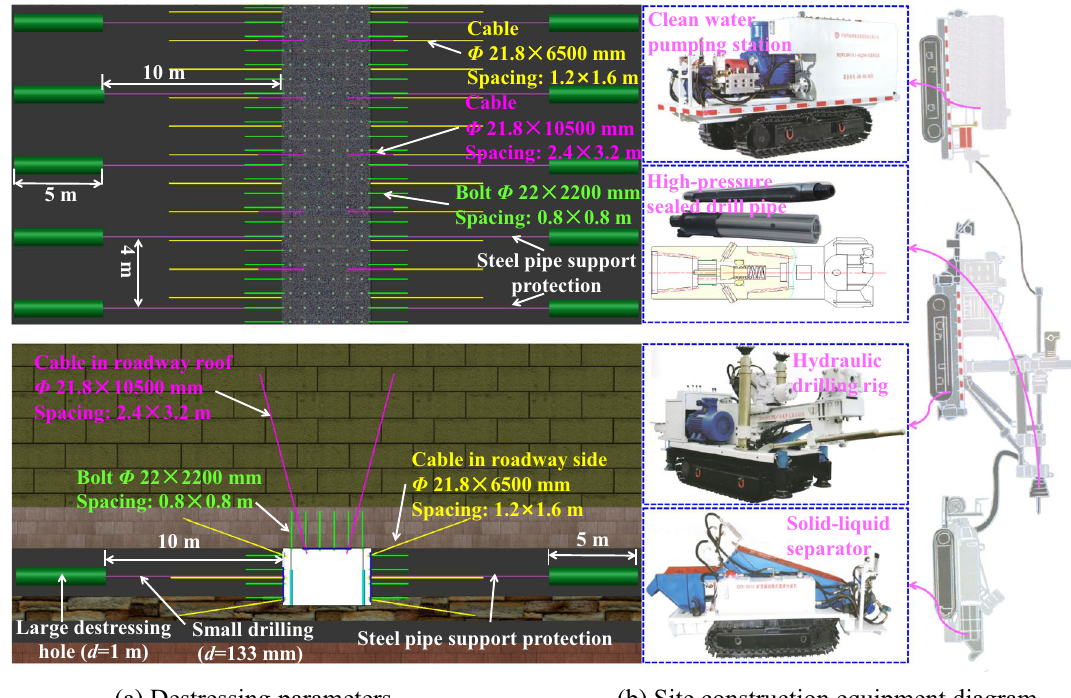
(a) Destressing parameters (b) Site construction equipment diagram. Figure 15. Destressing parameters and site construction equipment diagram.